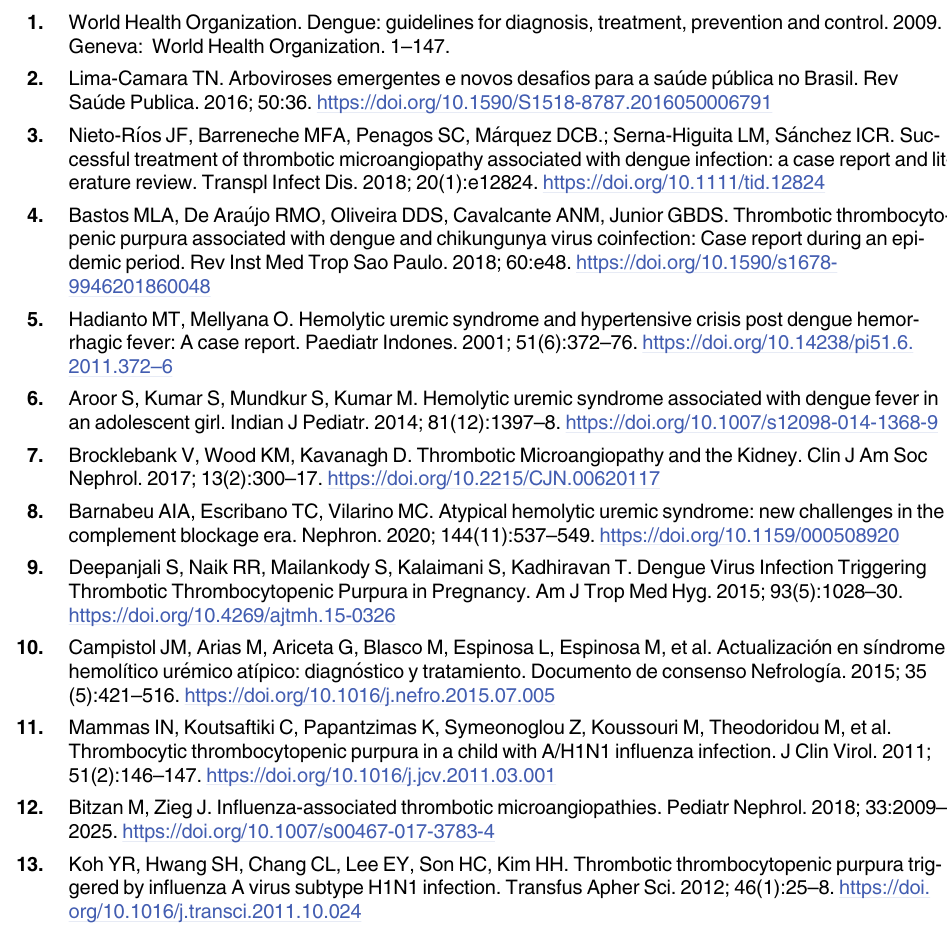
S1 Table. Reference ranges of laboratory